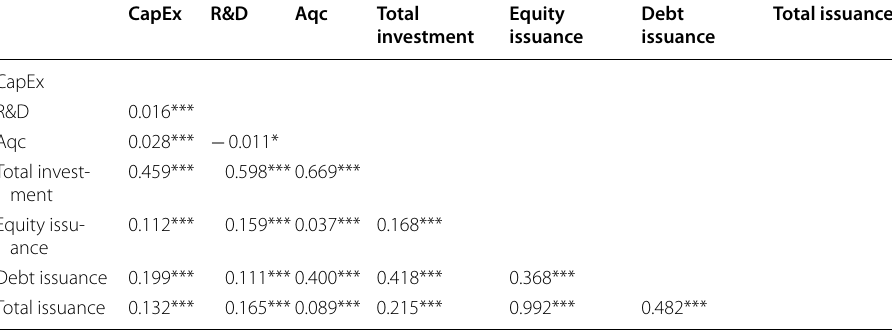
* denotes significance at the 10% level *** denotes significance at the1%